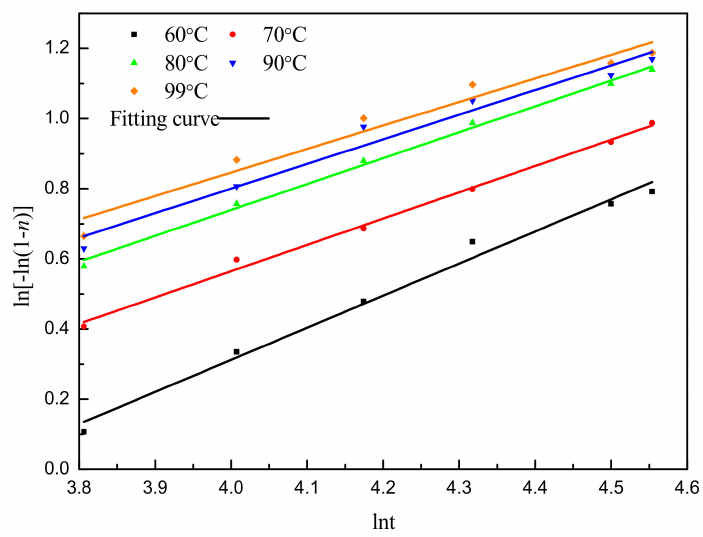
Figure 10. Relationship between ln [ − ln (1 − η )] and lnt at different temperatures. Table 3. Dynamic parameters at different